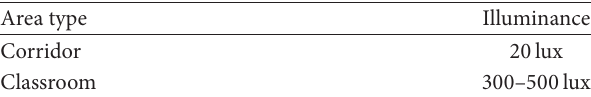
Table 7: Illuminance requirement from MS1525:2007 [8]. Table 8: Lighting system configuration that meets requirements.